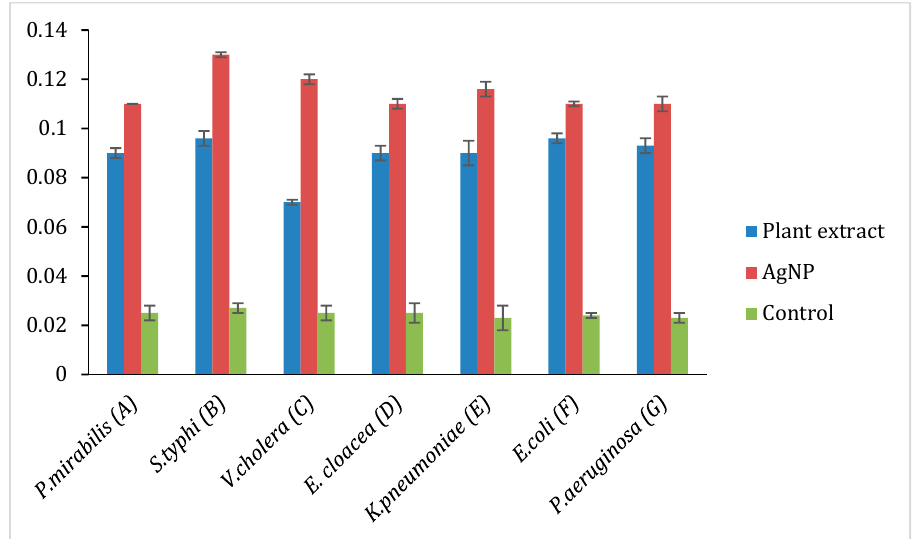
Figure 8. ROS production in selected Gram-negative bacteria A: Proteus mirabilis, B: Salmonella typhi , C: Vibrio cholera , D: Enterobacter cloacae , E: Klebsiella pneumoniae , F: E. coli , G: Pseudomonas aeruginosa .